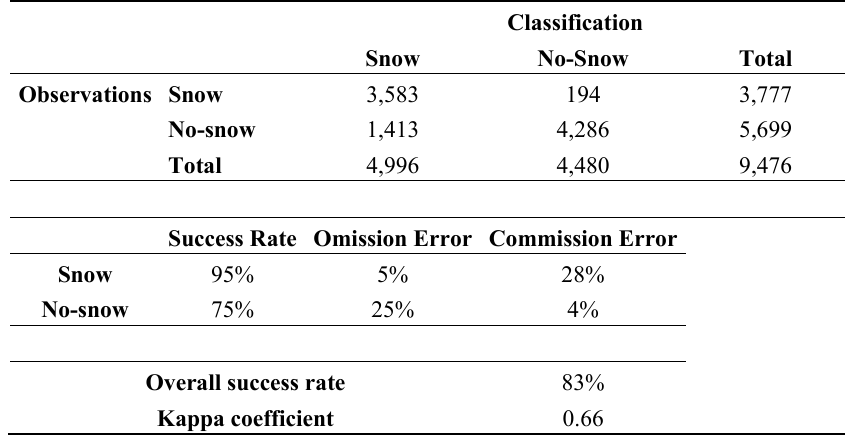
Table 5. Validation of the SSM/I algorithm using ground observations of snow from the 20 validation meteorological stations for the period from 1988 to